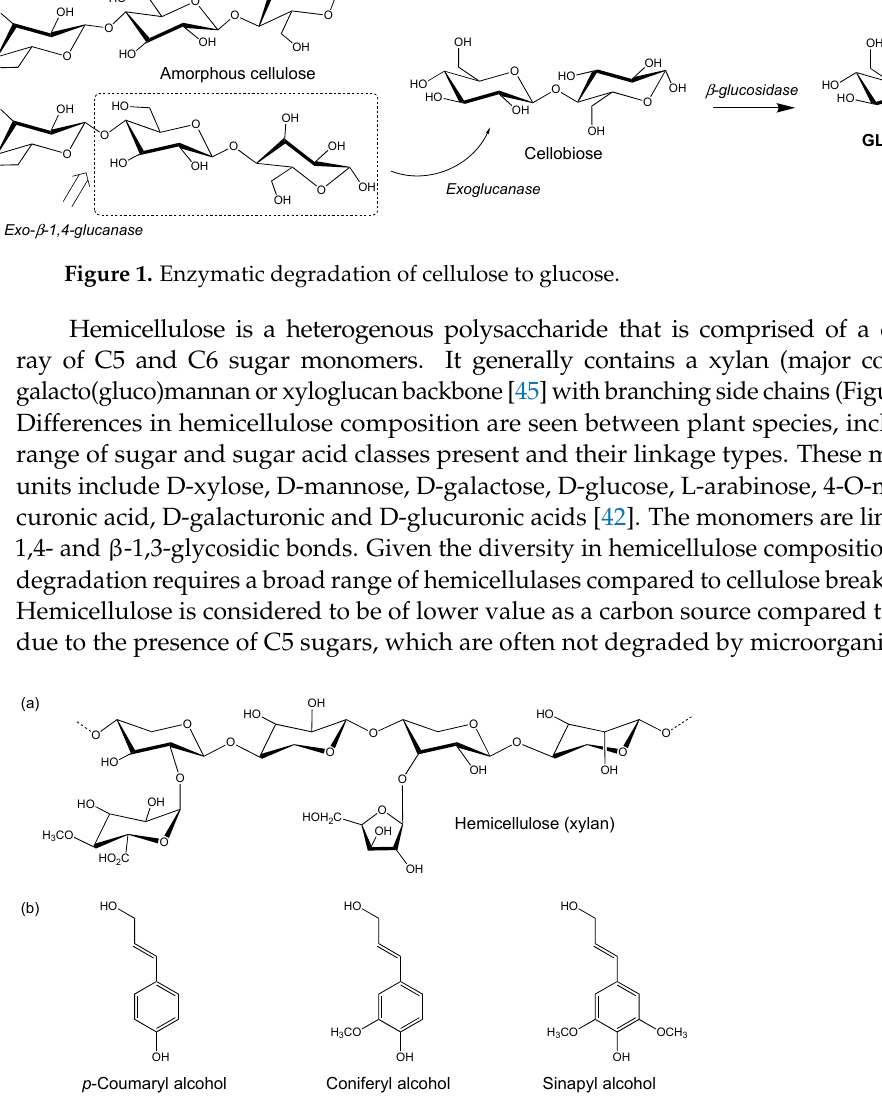
Figure 2. Example structures of ( a ) hemicellulose (xylan) and ( b ) monomers of lignin. Lignin is a complex heteropolymer composed of units of phenylpropane derivatives, such as p -coumaryl-, coniferyl- and sinapyl alcohols (Figure 2b) [42]. These compounds are linked via C–C and C–O bonds, and form p -phenyl- (H type), guaiacyl- (G type) and syringyl (S type) structural monomers. Lignin is covalently linked to both cellulose and hemicellulose, and provides the plant with structural support and impermeability. It also functions as a resistance against microbial attack and oxidative stress. Given these char- acteristics, lignocellulose requires pre-treatment to remove lignin to release the cellulose prior to enzymatic saccharification. Lignin is generally not considered to be a target car- bon source for microorganism cultivation, but instead is a source of valuable phenolic synthons for the production of high-value compounds [49,50]. 2.2. Lignocellulose Pre-Treatments Currently, most commercial and pilot scale processes utilising lignocellulose as a feedstock require physical and/or chemical pre-treatments to remove hemicellulose and lignin, reduce the crystallinity of the cellulose and minimise the release of hemicellulose- derived inhibitory compounds (e.g., furfural). The resultant amorphous regions of the cel- lulose then undergo enzymatic hydrolysis by commercial cocktails of cellulolytic enzymes to release glucose for later fermentations [51]. There are four main classes of lignocellulose pre-treatment strategies tested for their effectiveness in releasing amorphous cellulose with minimal inhibitory compounds. The first are purely physical techniques designed to break down the size of cellulose fibres and degrade lignin and hemicellulose. These tech- niques include size reduction (chipping, grinding and milling), microwave irradiation, ultrasound and high-pressure homogenisation [41]. These energy-intensive processes suc- cessfully reduce the crystallinity of the cellulose, but are generally not commercially viable options. A second group of pre-treatments are physio-chemical processes, such as steam ex- plosion and hot liquid water treatment [41]. Steam explosion treatment is an effective pro- cess, leading to the breakage of the fibres, allowing easy access of enzymes to the cellulose for hydrolysis to occur. It also causes delignification and solubilisation of hemicellulose. However, hemicellulose transformation is incomplete, and toxic compounds are released. Chemical treatments with acids [52], alkalis [53], oxidation agents, biological solvents [54] and aqueous–organic solvents have also been devised with mixed success [41]. They often successfully remove lignin with low inhibitor release, but suffer from high reagent costs and the need for corrosion resistance in scaled equipment. The final class of pre-treat- ments is purely biological, where cellulolytic microorganisms are used to partially decom- pose the lignocellulose to break up its structure. Typical microorganisms used include brown, white and soft rot fungi, with higher yields of glucose release after later enzymatic treatments due to increased cellulose purity. The disadvantage of biological treatments is the lower reaction rates, with extended residence times needed for efficient breakdown of lignocellulose [41].